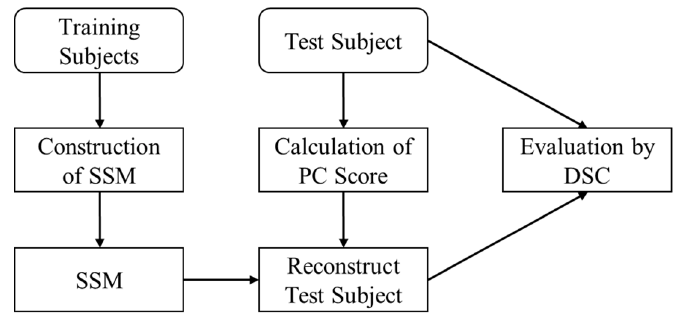
Figure 8. Schematic diagram of SSM validation.